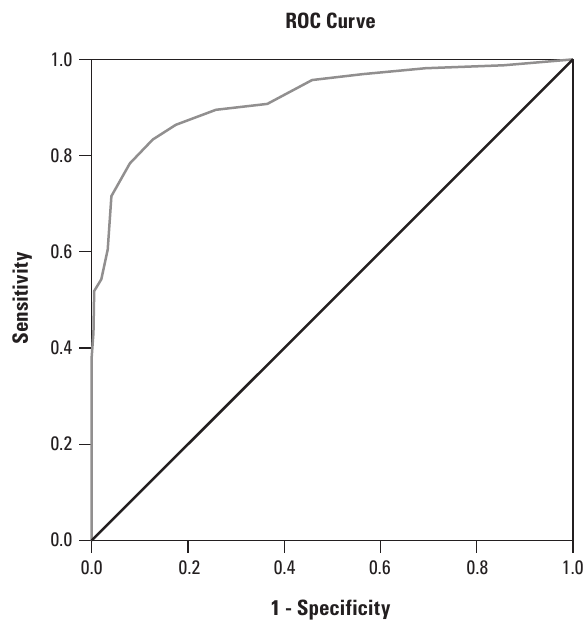
Figure 1. ROC curve of total